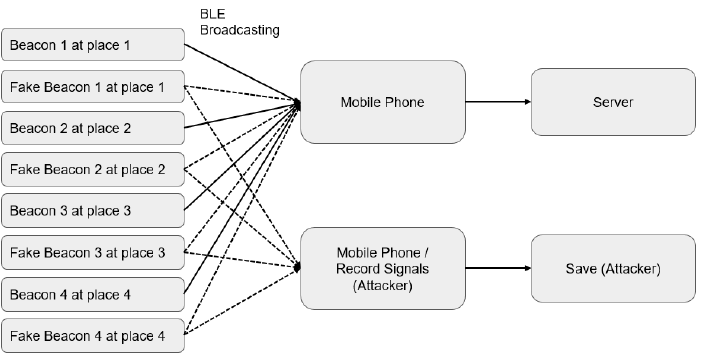
Figure 8. iBeacon hacker sends other users’ messages or broadcasting his/her own services via a mobile phone to disguise as a Beacon.